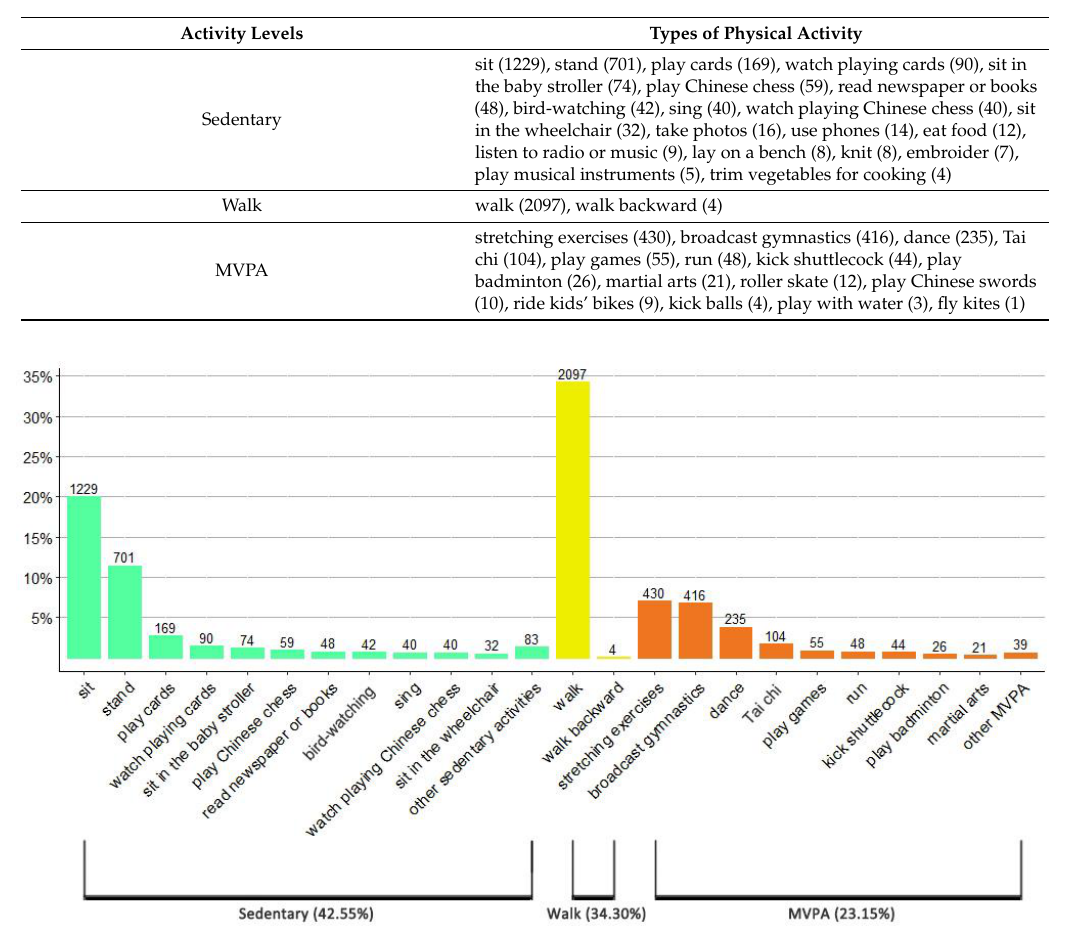
Figure 4. Observed predominant activities (in which over 30 people participated) by physical activity levels.